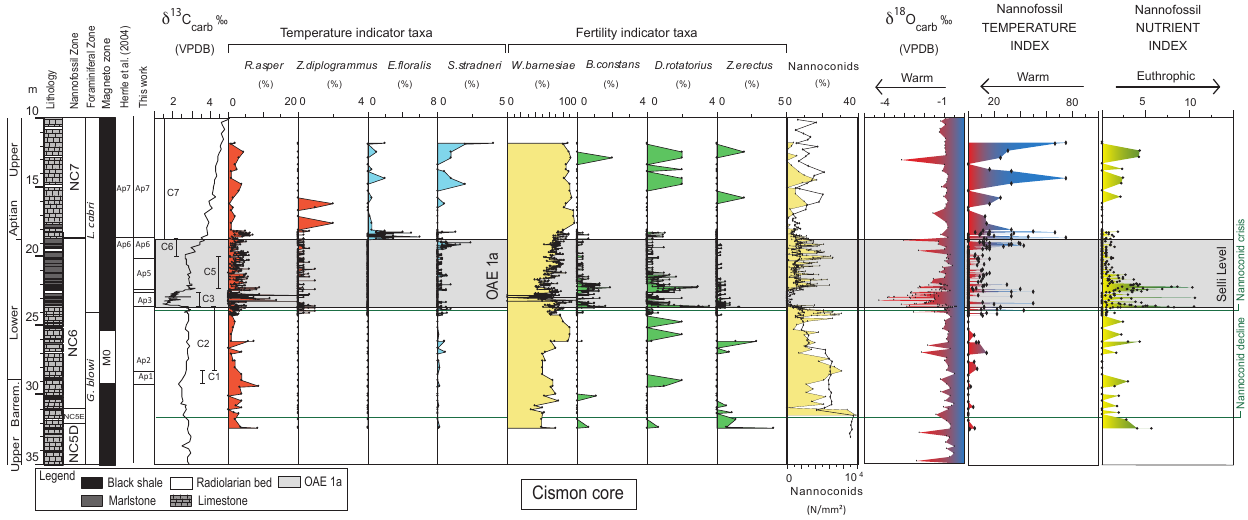
Figure 3. Cismon core: fluctuations of calcareous nannofossil temperature and fertility indicator taxa. Temperature (TI) and nutrient (NI) indices based on calcareous nannofossils (low values of the TI indicate high temperatures and vice versa; high values of the NI indicate high surface-water productivity and vice versa). δ 13 C is from Erba et al. (1999) and Méhay et al. (2009). Nannofossil and foraminiferal biostratigraphy is from Erba et al. (1999). Magnetostratigraphy is from Channell et al. (2000). Bulk δ 18 O data are from Erba et al. (2010).